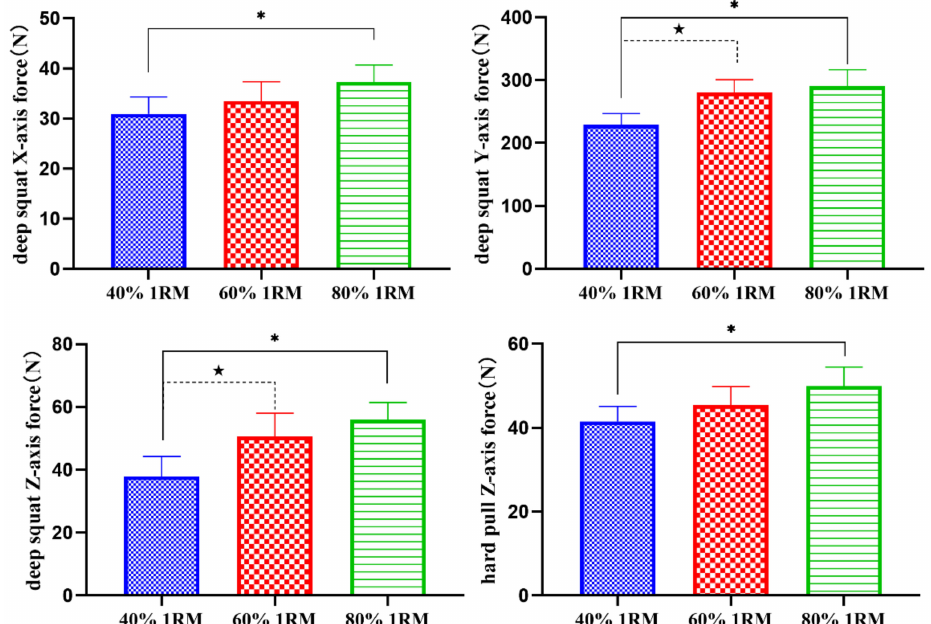
Figure 9. Comparisons of the different force on knee joint (N). * There was a significant difference between 40% 1RM and (cid:70) 80% 1RM ( p < 0.05). There was a significant difference between 40% 1RM and 60% 1RM ( p < 0.05).